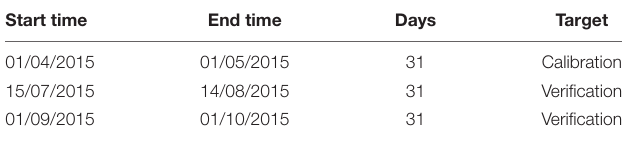
TABLE 1 | Calibration and verification of MIKE 21 model.